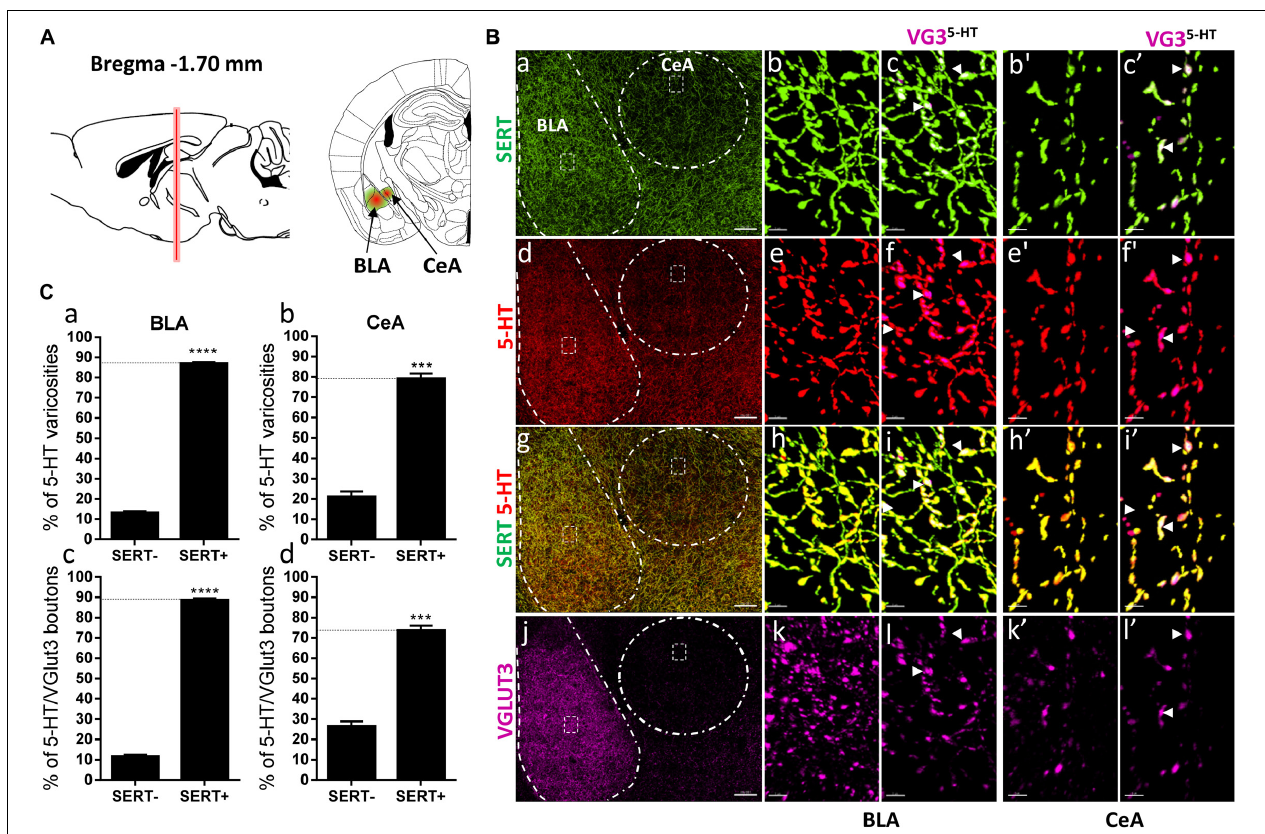
FIGURE 6 | Distribution of VGLUT3 + boutons within 5-HT + and SERT + axons in the basolateral amygdala and central nucleus of the amygdala. (A) Schematic drawing showing the location of the acquired micrographs. The basolateral amygdala (BLA) and central nucleus of the amygdala (CeA) mosaic images were acquired at bregma –1.70 ± 0.2 mm (red vertical line) in the anterior part of the basolateral amygdala and the lateral CeA (green/red areas). (B) Micrograph showing the distribution of the SERT (green, a–c,b’,c’ ), 5-HT (red, d–f,e’,f’ ), SERT (green) + 5-HT (red) (g–i,h’,i’) , and VGLUT3 (magenta, j–l,k’,l’ ) in the CeA and BLA. Left panel (a,d,g,j) shows lower magnification. Scale bar: 150 µ m. Middle (b,e,h,k and b’,e’,h’,k’) and right (c,f,i,l and c’,i’,f’,l’) panels show higher magnification of the white dashed areas in the left panel (a,d,g,j) . Scale bar: 2 µ m. The right panels (c,f,i,l and c’,f’,i’,l’) shows the VGLUT3 boutons co-labeled with SERT (c,c’) , 5-HT (f,f’) , and SERT + 5-HT (i,i’) in the BLA and CeA. VGLUT3 puncta located within 5-HT varicosities were isolated using Imaris (l,l’) . Arrowheads show 5-HT varicosities collocated with SERT and VGLUT3 (c,f,i,l and c’,f’,i’,l’) . (C: a,b) Quantification of the proportion of 5-HT varicosities not co-labeled (SERT - ) and co-labeled (SERT + ) with SERT in the BLA (a) and CeA (b) , showing a great majority of 5-HT varicosities co-labeled with SERT. (c,d) Quantification of the proportion of 5-HT + /VGLUT3 + not co-labeled (SERT–) and co-labeled (SERT + ) with SERT in the BLA (c) and CeA (d) , showing a great majority of 5-HT + /VGLUT3 + varicosities co-labeled with SERT ( t -test, ∗∗∗∗ p < 0.0001; ∗∗∗ p <